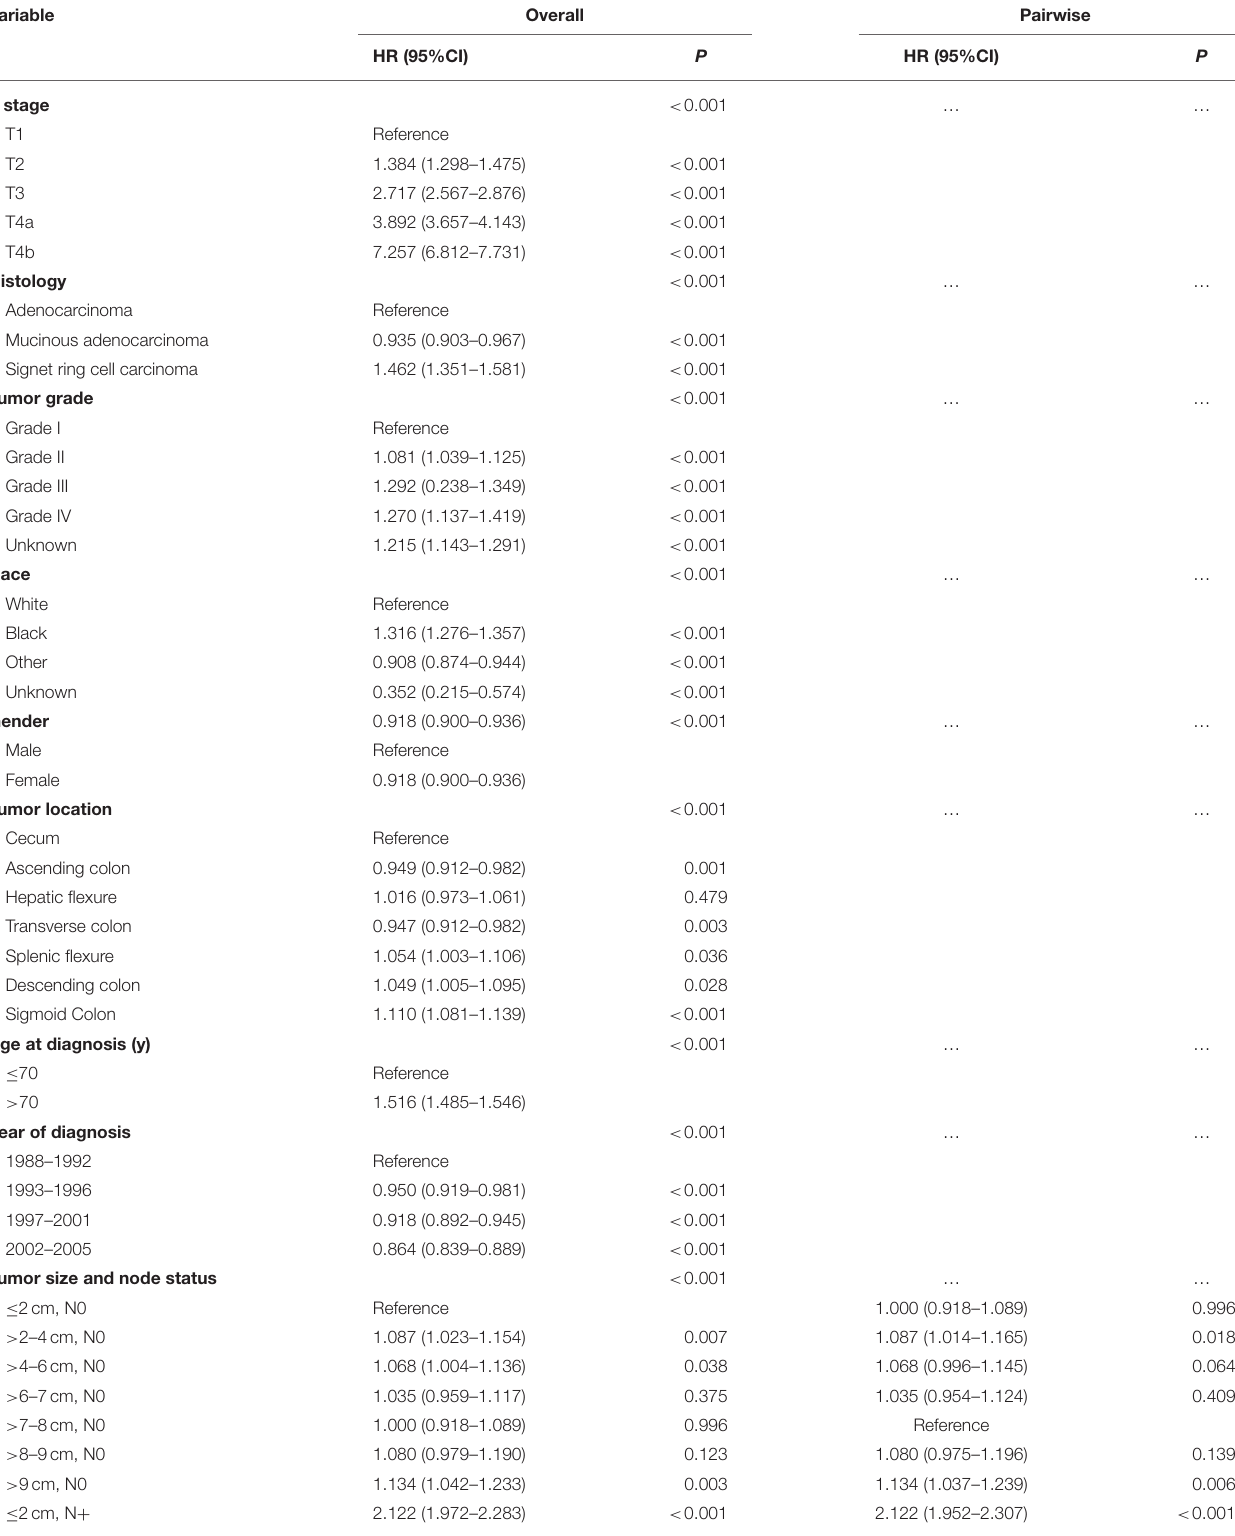
TABLE 1 | Multivariate Cox regression analyses of CSS in SEER cohort.